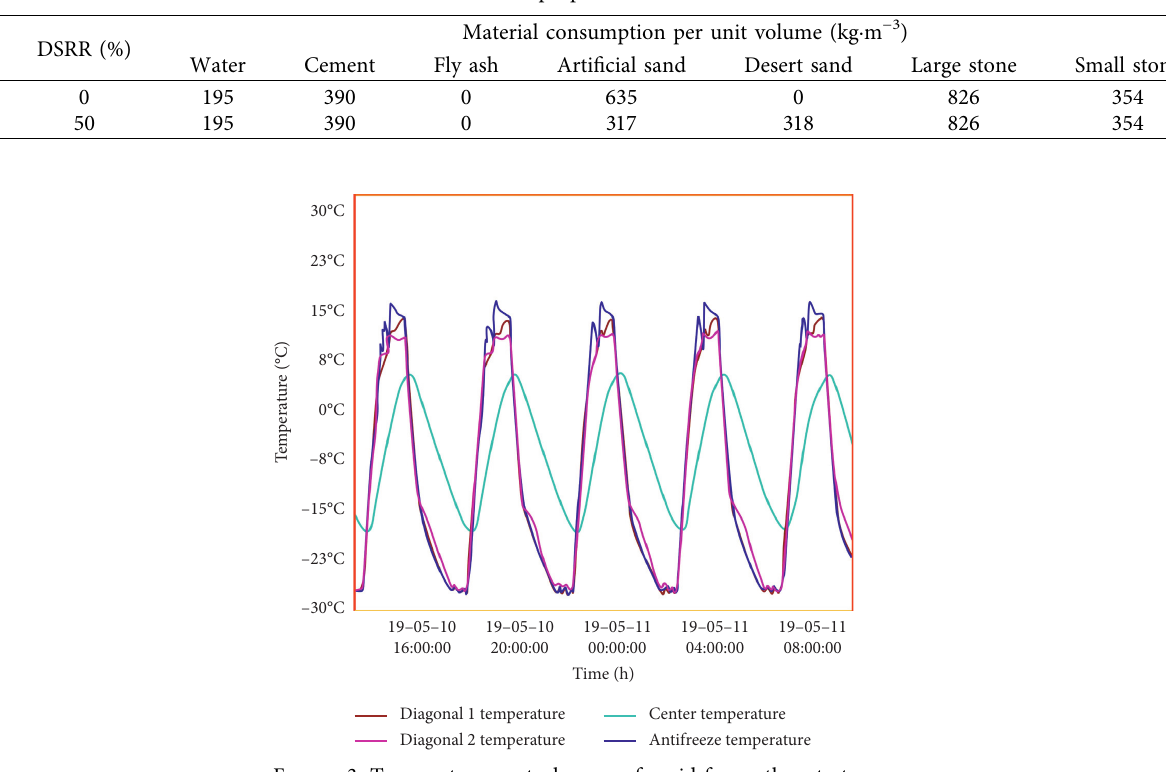
Table 4: Mix proportion of DSC.